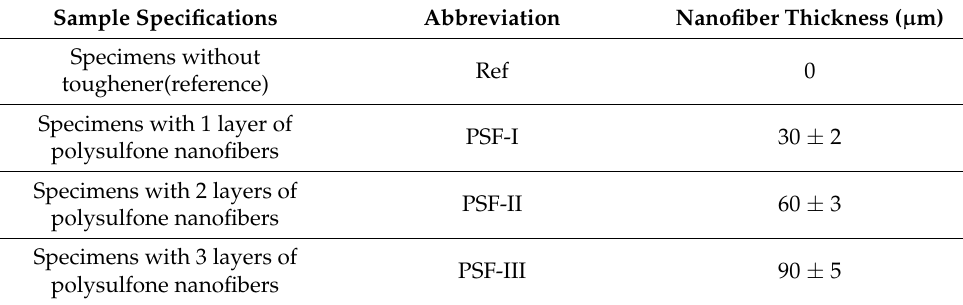
Table 1. The specification of samples and their abbreviations.